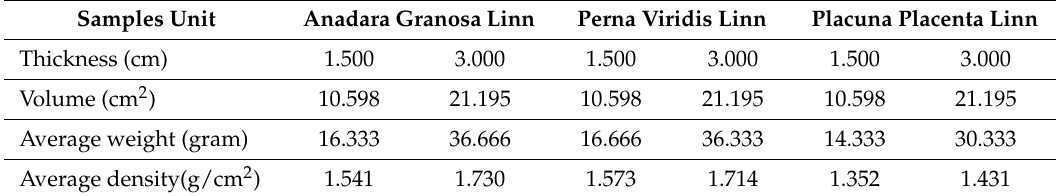
Table 2. The average density of the test specimens of shell fiber reinforced